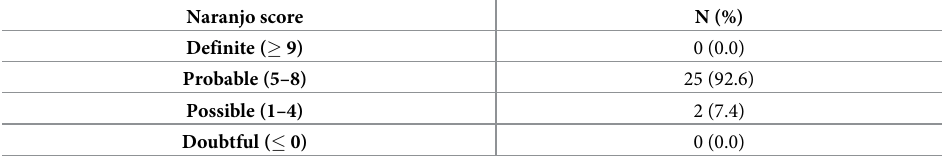
Table 1. Naranjo score of patients with observed